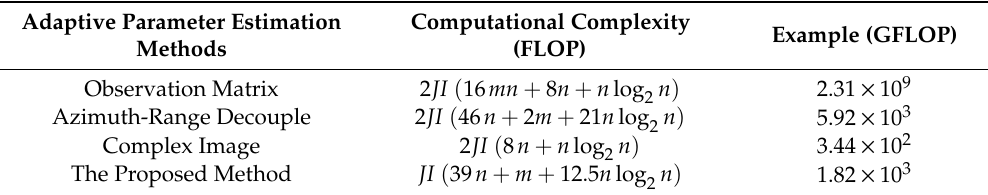
Table 1. The computational complexity of di ff erent adaptive parameter estimation